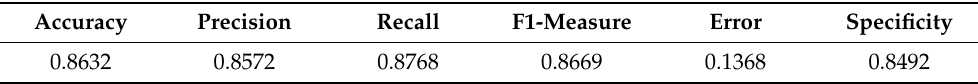
Table 3. Performance evaluation of our system.